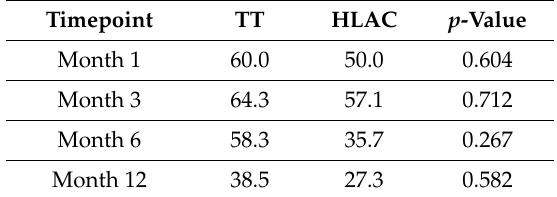
Table 5. Proportion of participants meeting 75% adherence benchmark.